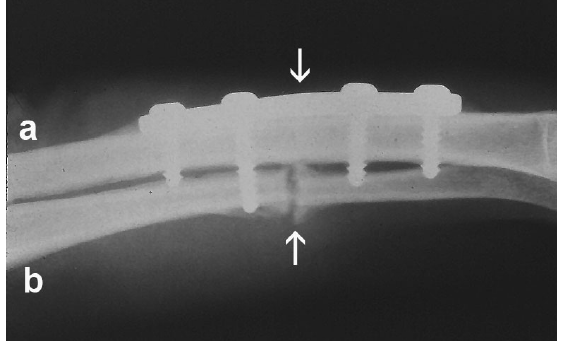
Figure 1. Fracture healing in two different mechanical strain environments. Fracture sites are indicated by arrows. The radius ( a ) fixed with a rigid plate, and experiencing minimal mechanical strain, is healing by direct osteonal repair. The ulna ( b ), which is in a more flexible mechanical environment, and is experiencing motion and strain, is healing by endochondral bone formation. For both the radius and the ulna, the ECM and gene expression of the repair are being regulated by the biophysical environments. Reproduced with permission from Aaron RK, Bolander ME (eds). Physical Regulation of Skeletal Repair. Rosemont, IL: American Academy of Orthopaedic Surgeons; 2005.